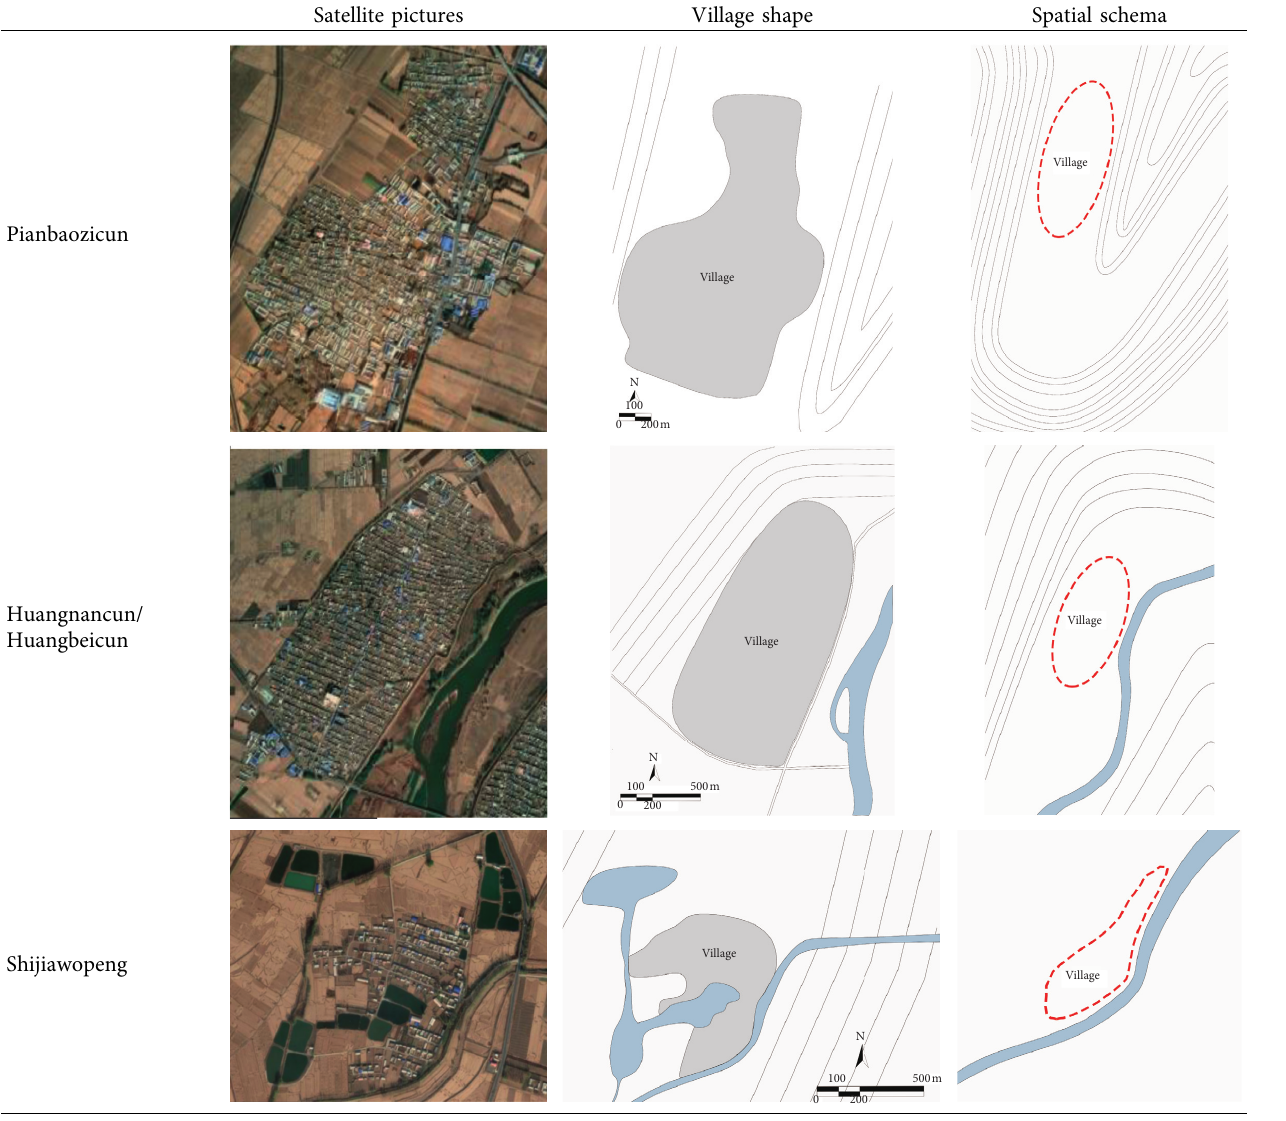
Table 7: Spatial morphological characteristics of villages in Ciyutuo Subdistrict in